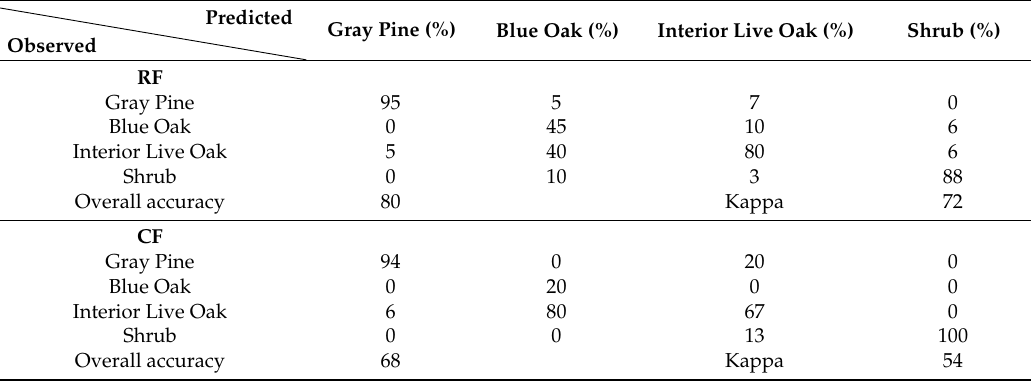
Table 5. Confusion matrix for vegetation classification using RF and CF methods with training data (OOB error) (testing proportion = 0.2).